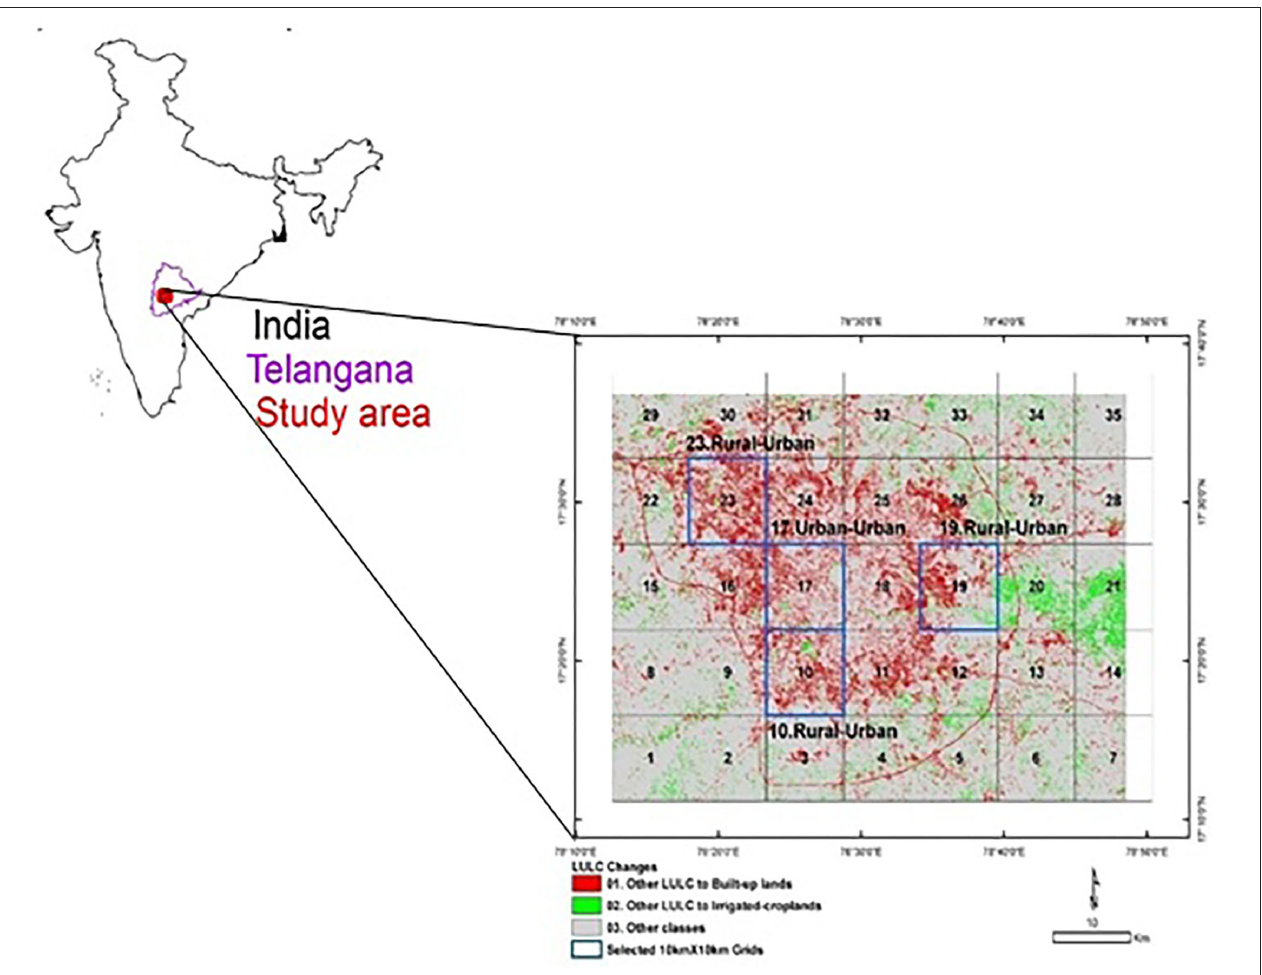
FIGURE 1 | The grid of locations selected on the basis of GIS data for a study of the COVID-19 lockdown’s impact on household food security in Hyderabad, India [based on Gumma et al. (